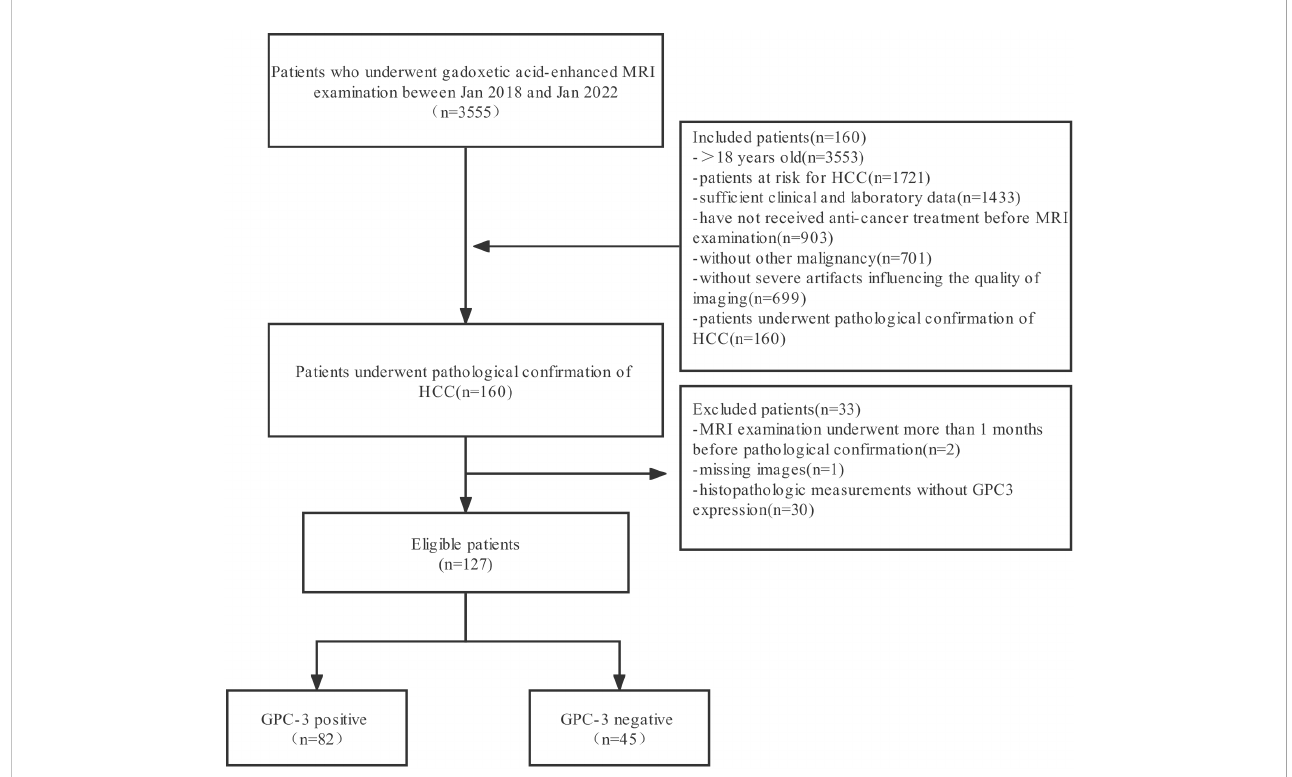
FIGURE 1 The work fl ow of patient selection for this